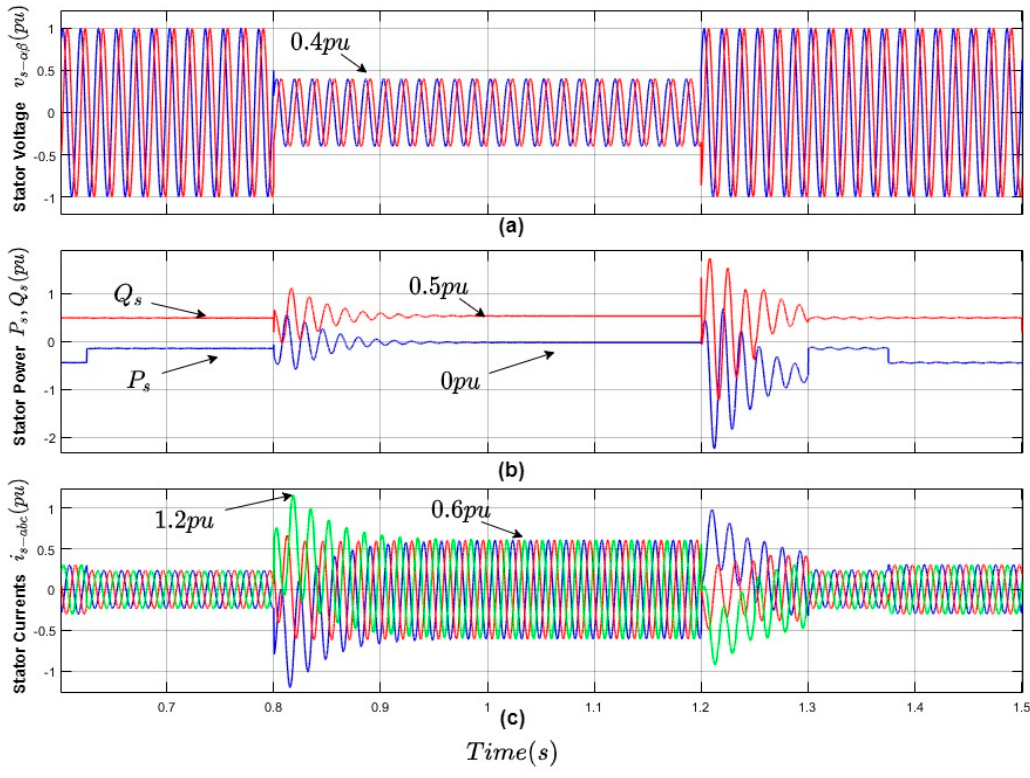
Figure 13. DFIG FRT performance during a voltage dip using the demagnetizing current and predictive control method; ( a ) stator voltage, ( b ) active and reactive power, ( c ) stator currents.